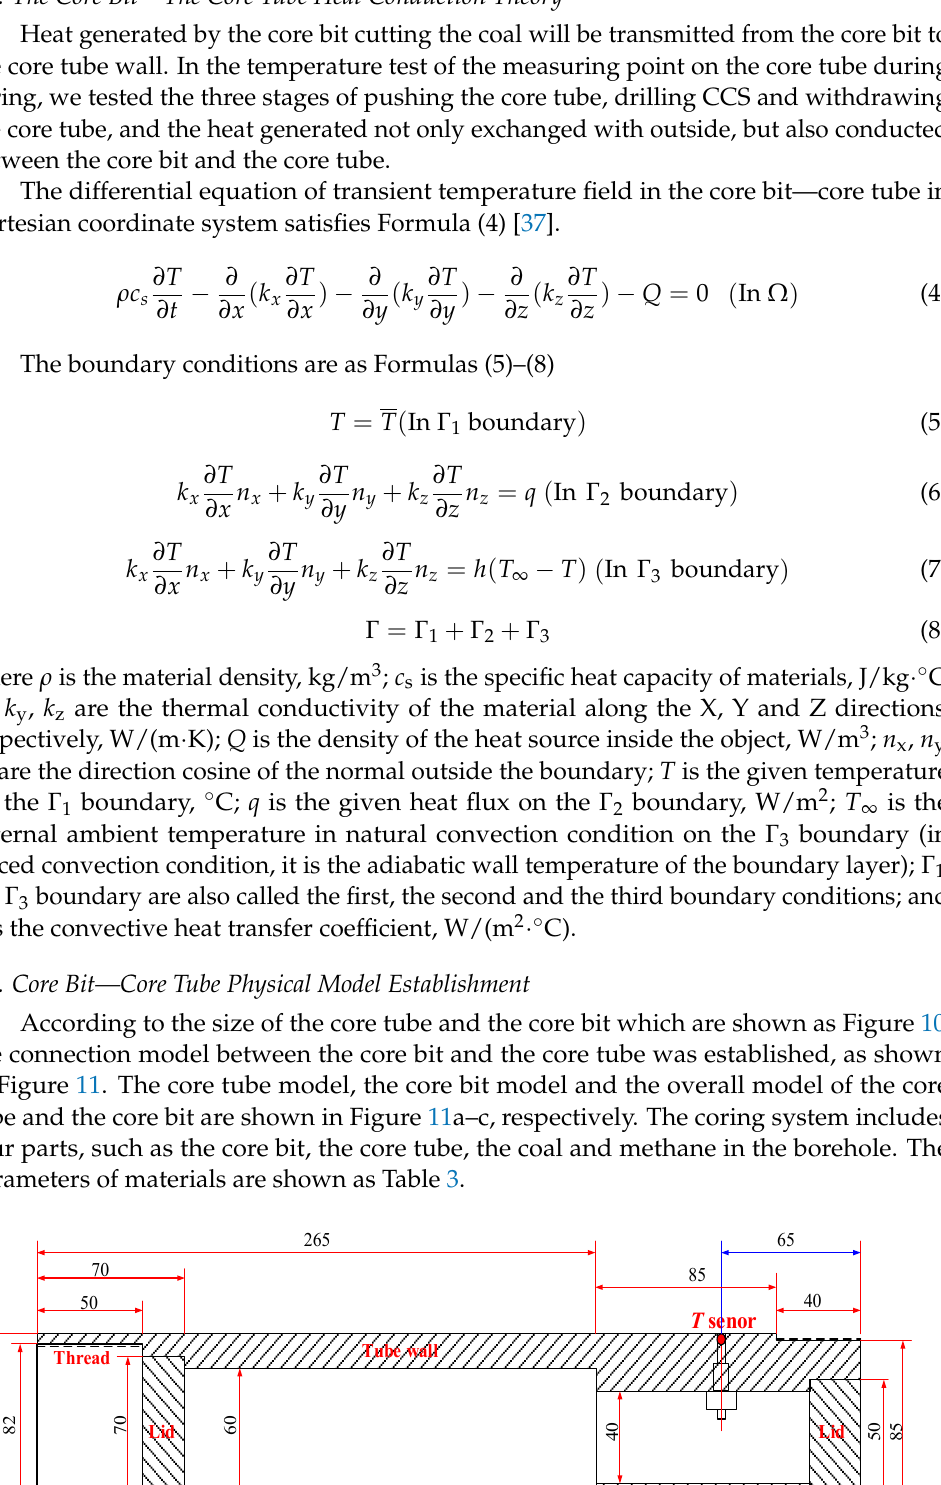
( a ) ( b ) ( c ) Figure 11. Core bit—core tube physical model: ( a ) temperature core tube model; ( b ) core bit model; and ( c ) integral model of core tube and drill bit. Table 3. Parameters of the model. Parameters